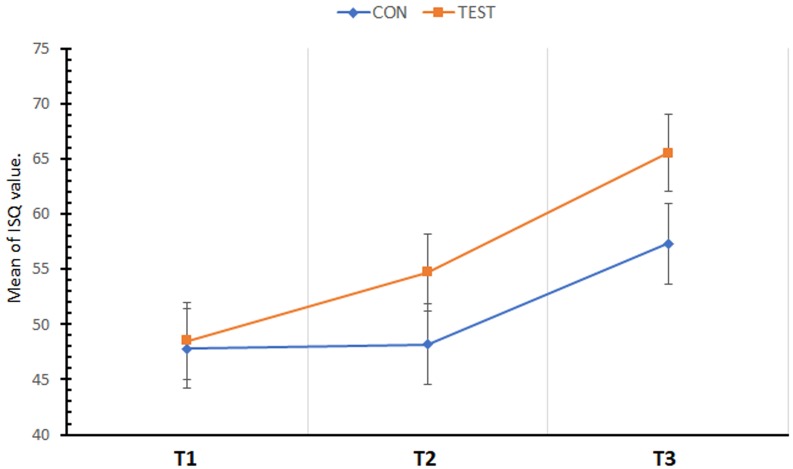
Line graph presenting the ISQ progression on the three times: T1 = immediately after the installation; T2 = 3 weeks; T3 = 4 weeks.*statistically significative (P < 0.05).